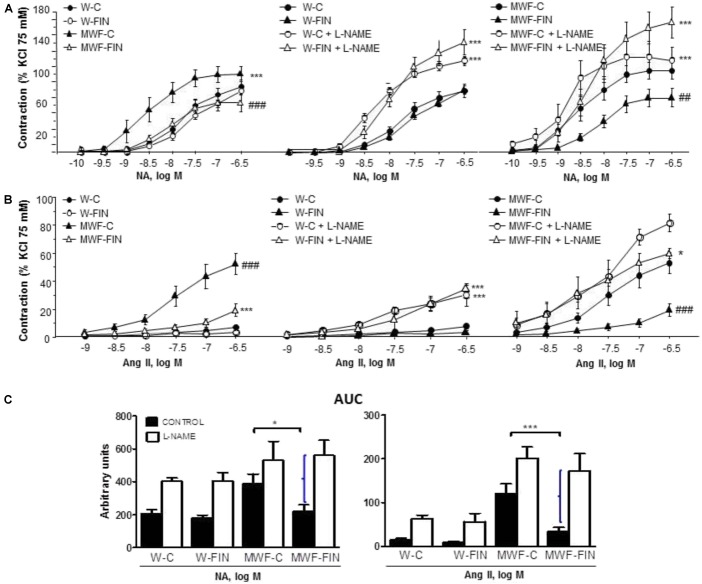
Effect of chronic treatment with finerenone on basal nitric oxide (NO) release. Concentration-response curves to (A) noradrenaline (NA, 10-10–5 × 10-7 mol/L) or (B) angiotensin II (Ang II, 10-9–5 × 10-7 mol/L) in aortic rings from W and MWF rats in absence an presence of L-NAME (10-4 mol/L). Data are shown as mean ± SEM of 10 animals per strain. (C) AUC, Area under concentration–response curves elicited by NA or Ang II in presence/absence L-NAME. AUC is expressed in arbitrary units. Curley bracket indicates NO availability. ∗p < 0.05; ∗∗∗p < 0.001 compared to their corresponding matched control groups. ###p < 0.001; ##p < 0.01 compared to their corresponding matched finerenone group. W, Wistar Kyoto; MWF, Munich Wistar Frömter; C, control; FIN, finerenone.